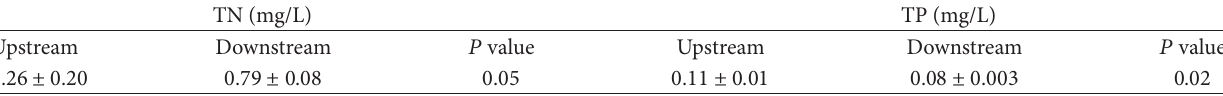
Table 1: Annual average concentrations of N and P in the water of upstream and downstream of experimental sites ( 𝑛 = 12). TN (mg/L) TP (mg/L) Upstream Downstream 𝑃 value Upstream Downstream 𝑃 value 1.26 ± 0.20 0.79 ± 0.08 0.05 0.11 ± 0.01 0.08 ± 0.003 0.02